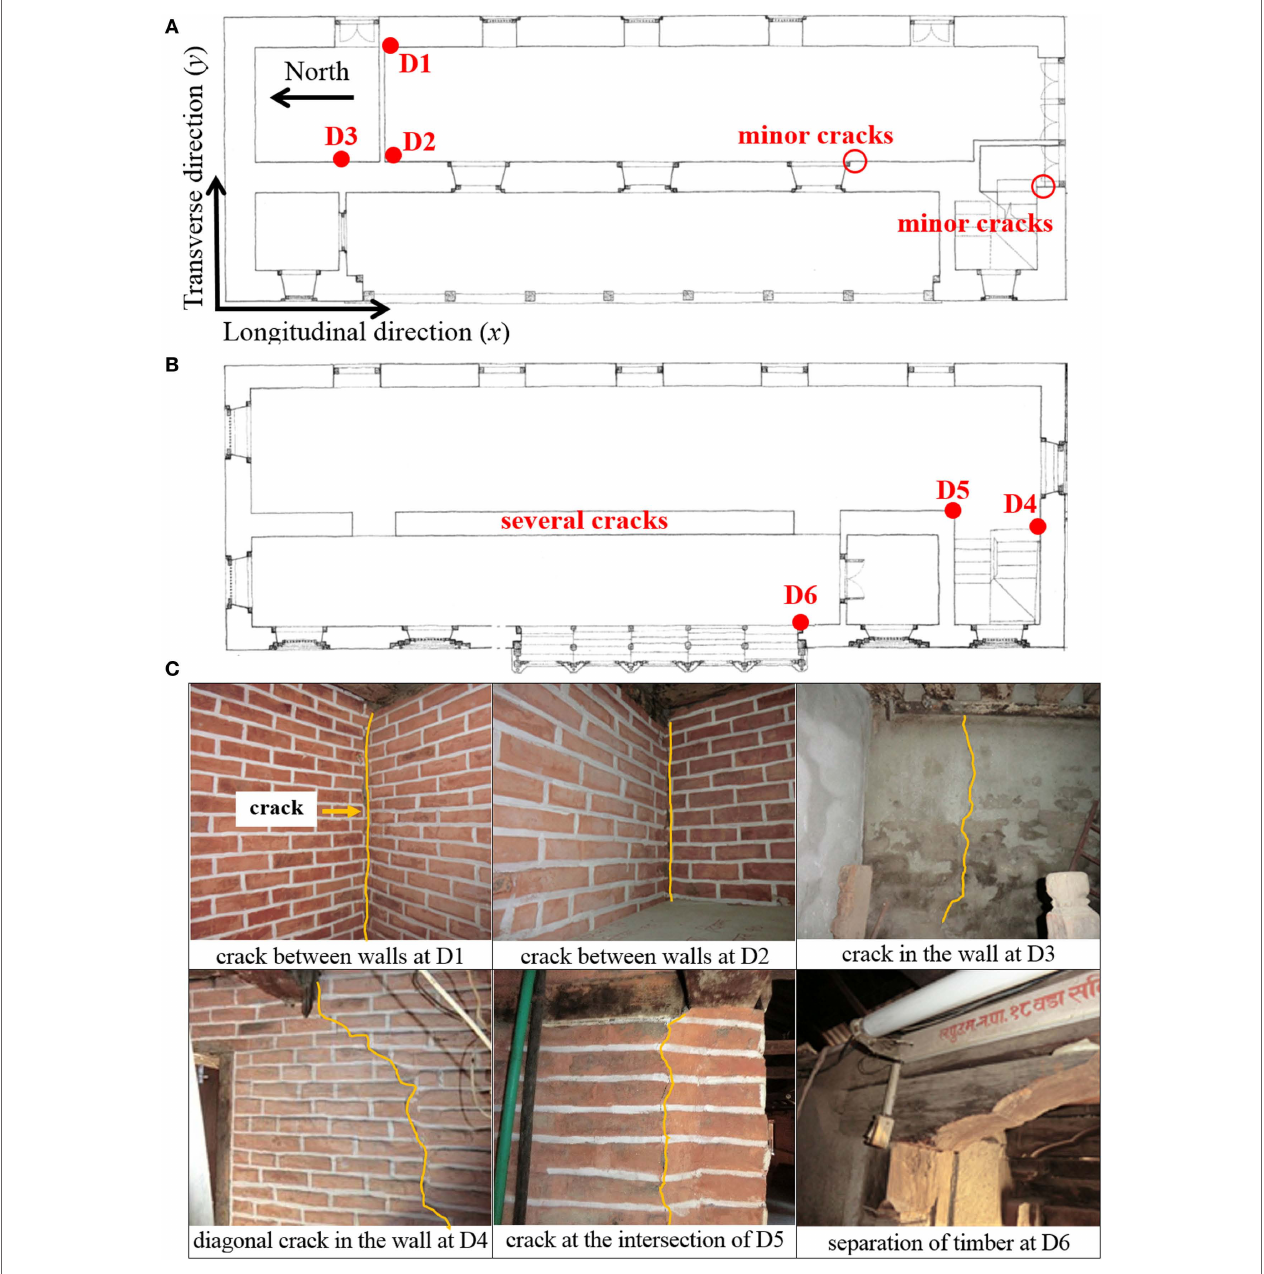
FIGURE 5 | Location and photographs of cracks found in the building after the 2015 Gorkha earthquake. (A) Location of cracks in the ground floor. (B) Location of cracks in the 1st floor. (C) Photographs of cracks found inside the building.